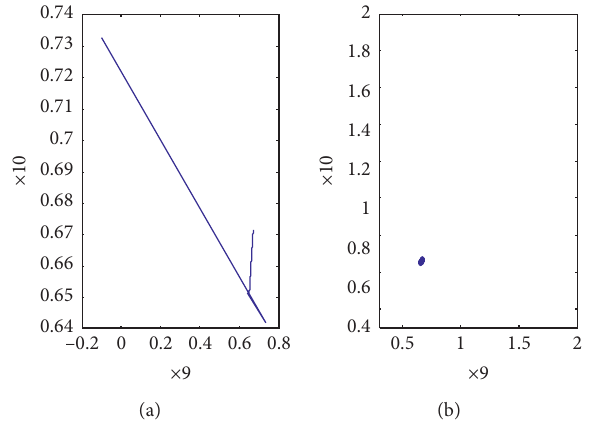
Figure 33: ω � 110 and k when t ∈ 0 . 05 0 . 0597 􏼂 􏼃 .